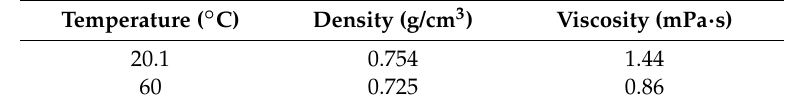
Table 1. The density and viscosity of kerosene used in the experiments at room and reservoir temperature.